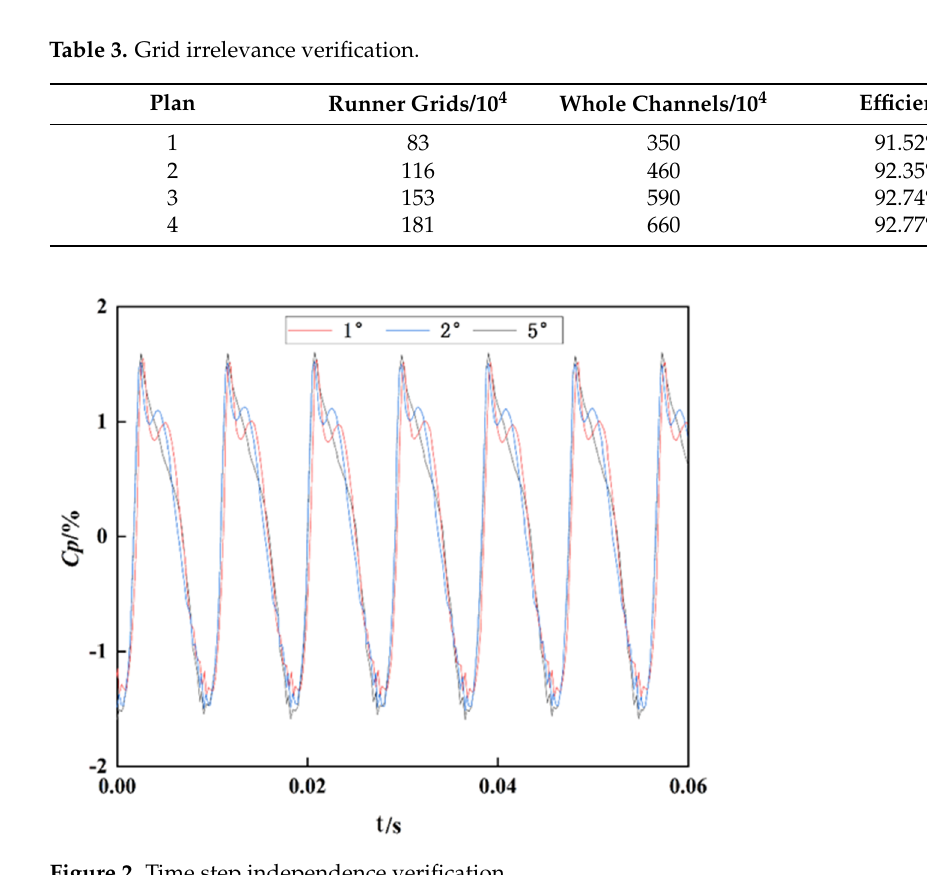
Table 3. Grid irrelevance verification. Plan